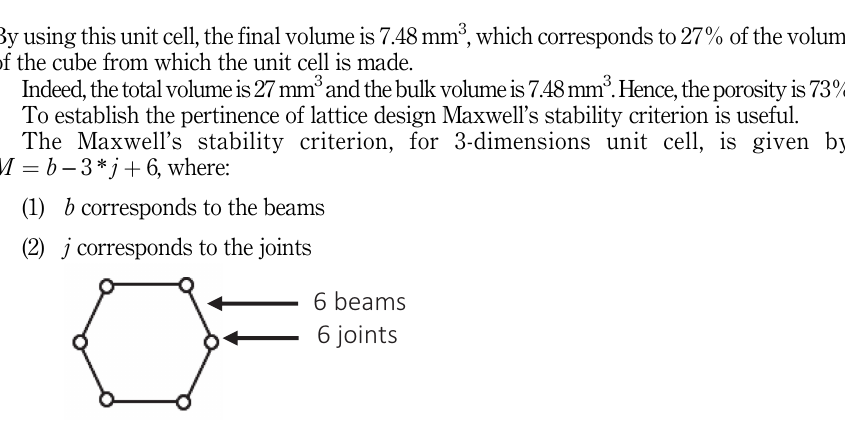
Figure 1. Dimensions of